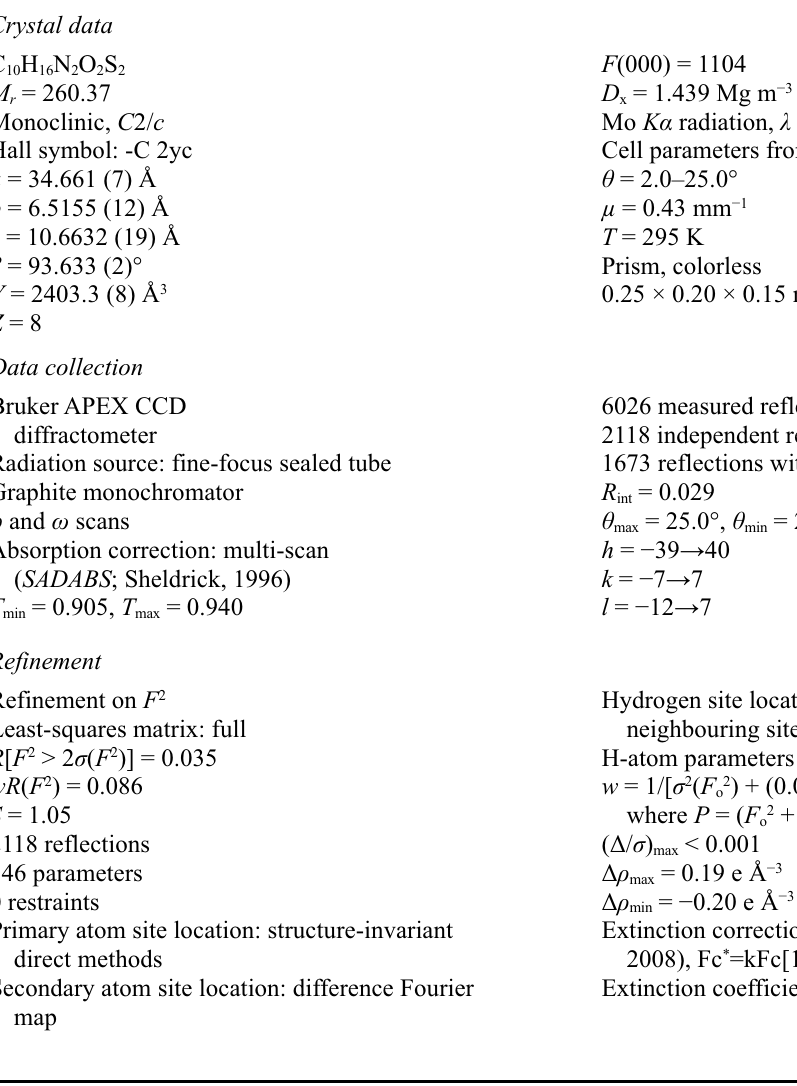
Figure 1 The molecular structure of the title compound with 30% probability displacement ellipsoids.